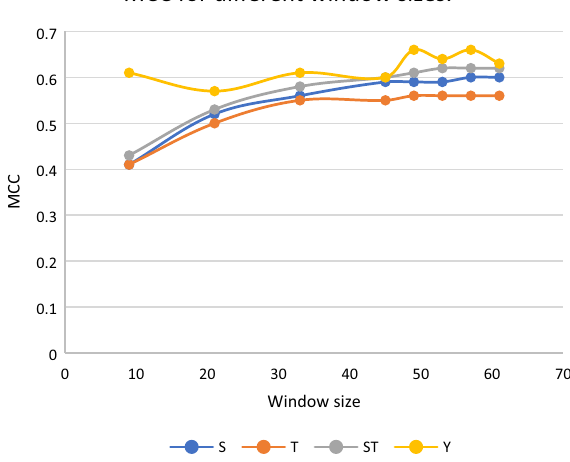
Figure 3. Tenfold cross-validation mean MCC of S, T, ST and Y for different window sizes.